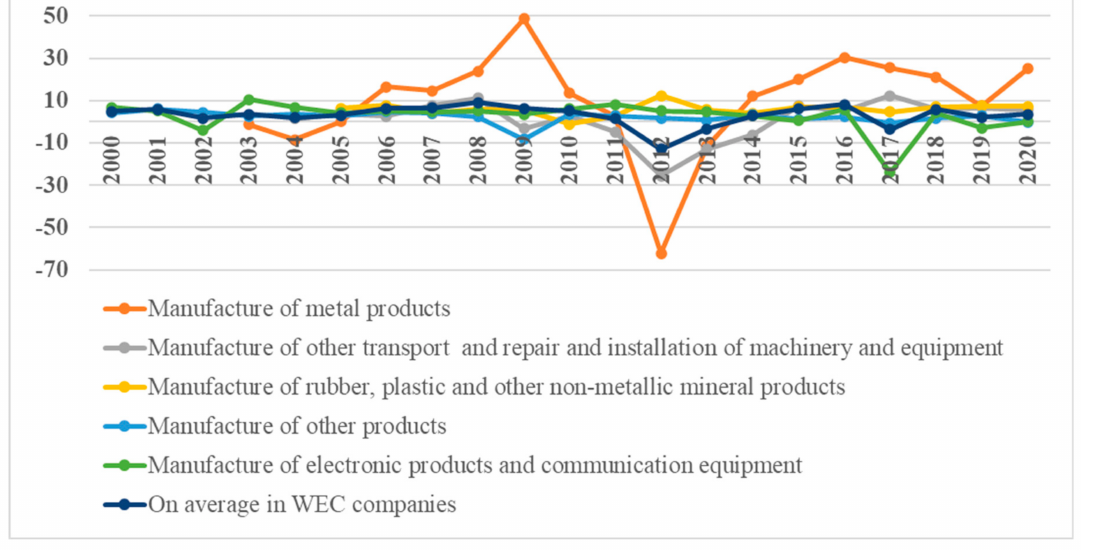
Figure 9. Net profitability,